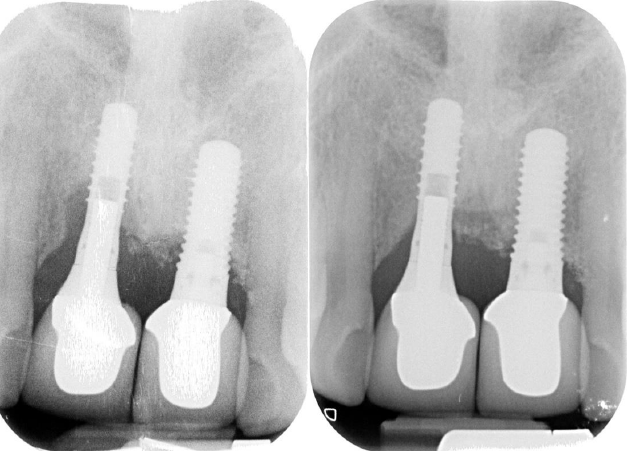
Figure 7. Peri-implantitis affecting upper central incisors and clinical resolution at the 35-month recall. All patients were put on a strict supportive therapy protocol with periodontal recalls every 3 months.